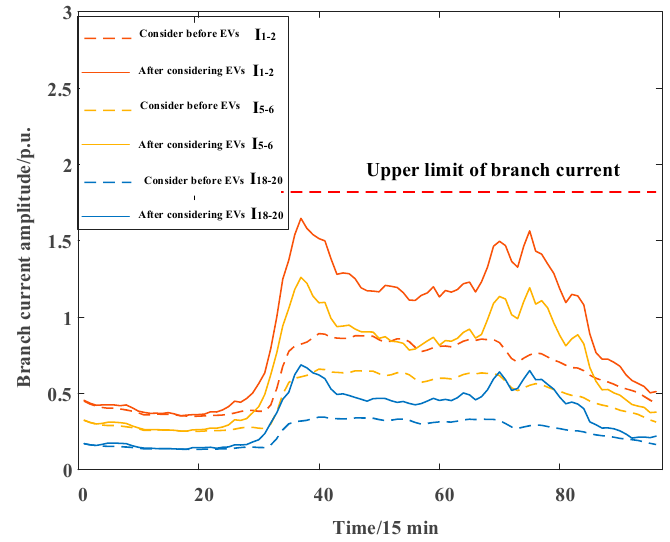
Figure 14. Consider the branch currents before and after EV access.